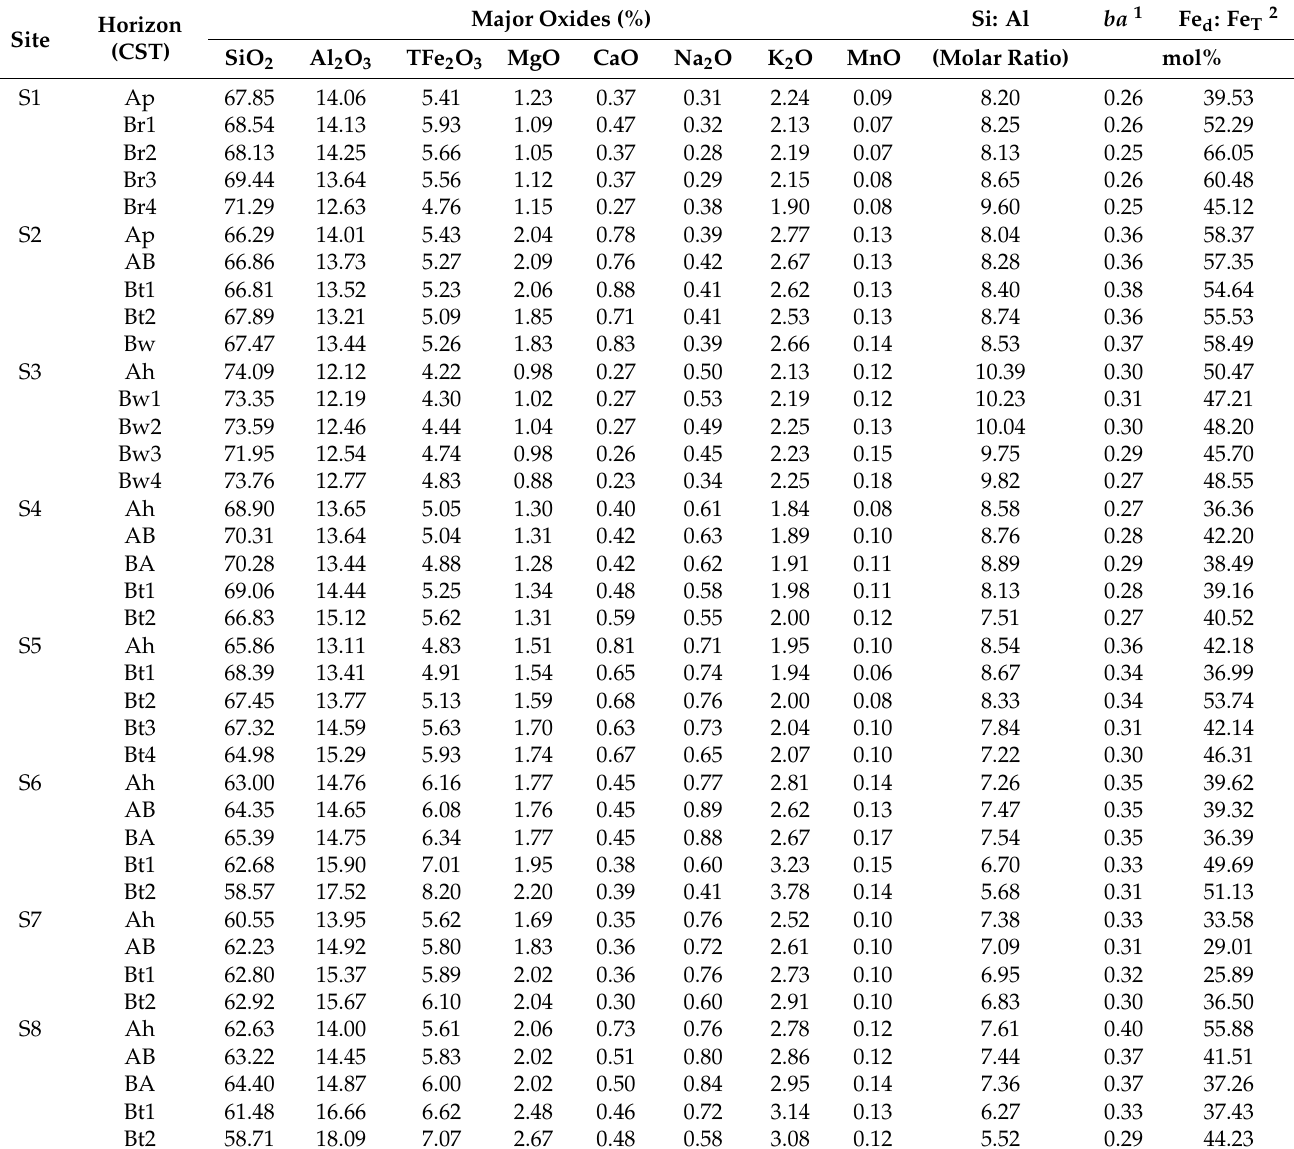
Table 3. Total major element composition and total elements’ content data for soils derived from carbonate rocks along a climosequence in a subtropical mountain,